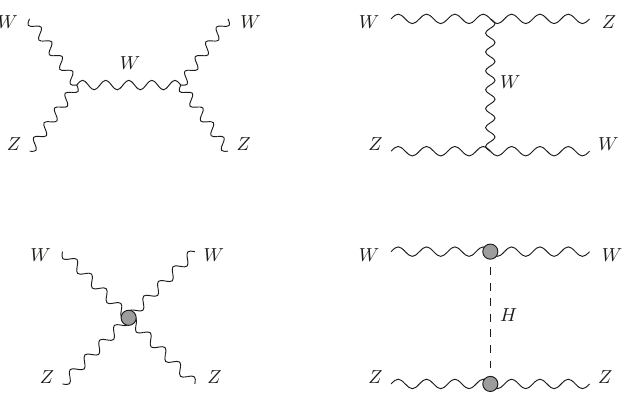
WZ ) EChL amplitude in the EChL tree !